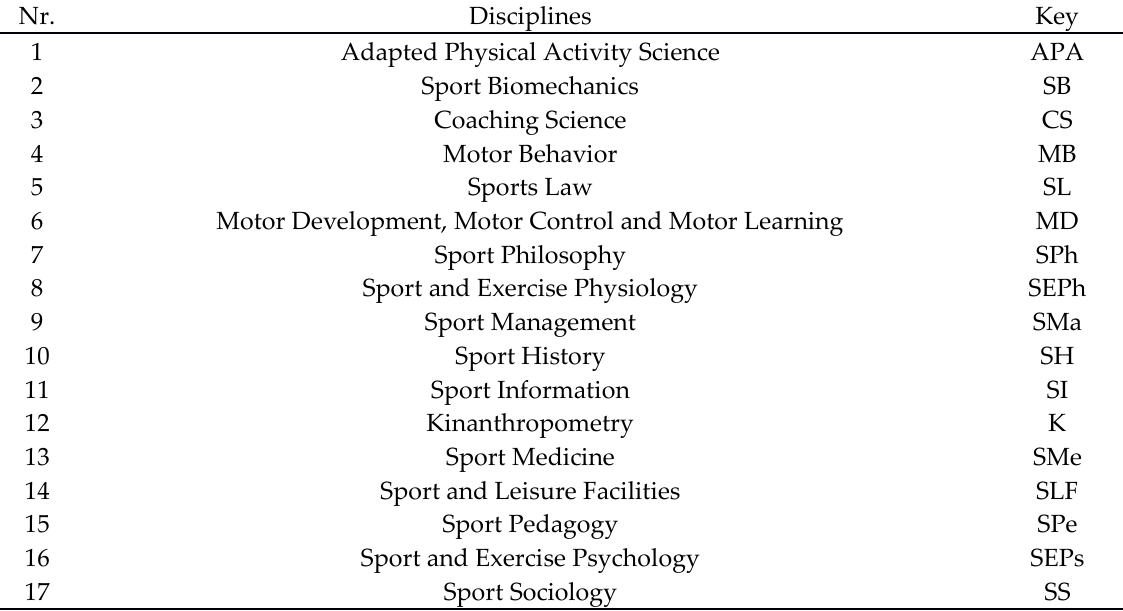
Table 2. Sport Science Disciplines approved by ICSSPE (Borms, 2008) Nr.